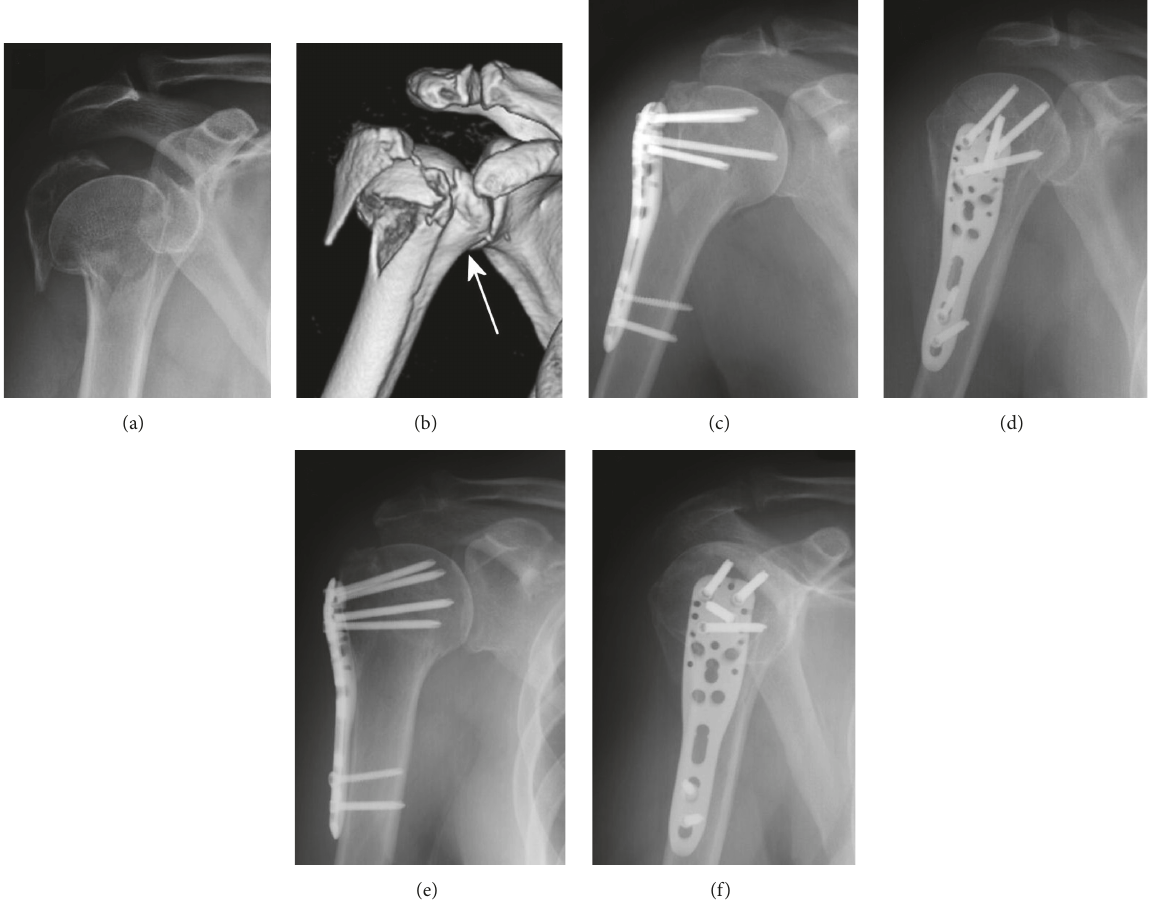
Figure 4: (a)-(b) Three-part valgus impacted fracture with severe displacement of the articular segment in a 48-year-old woman (AO/OTA type C2); the lesser tuberosity was in continuity with the shaft (arrow). (c)-(d) Postoperative radiograms in external (c) and internal (d) rotation showing anatomical reduction of the fracture. (e)-(f) The same radiographic views three months after surgery demonstrating union with no secondary